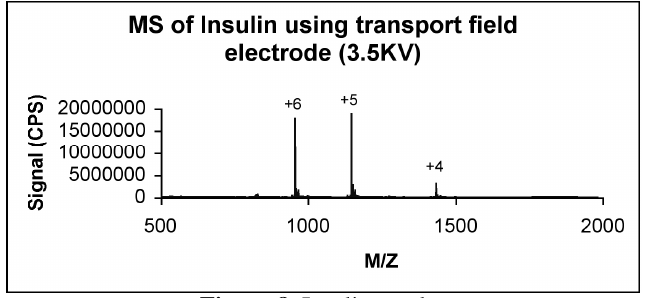
Figure 8 . Insulin results.